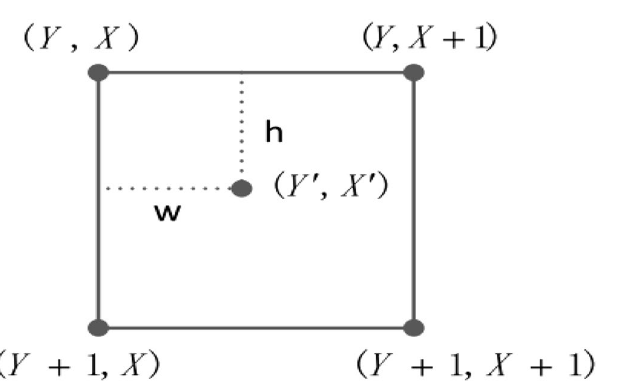
Figure 3. Coordinate map